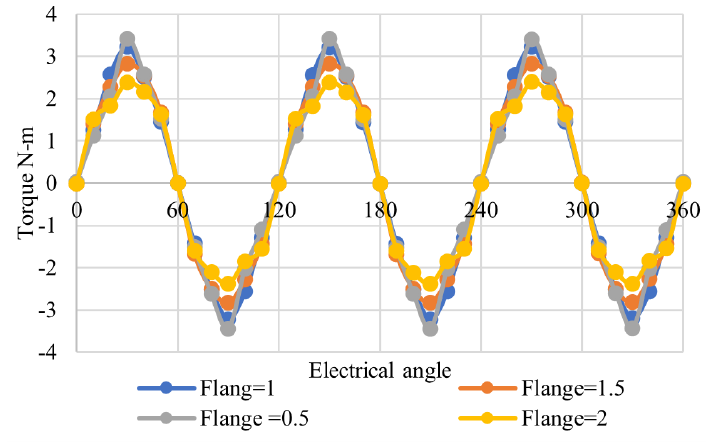
Figure 19. Different flanging results.